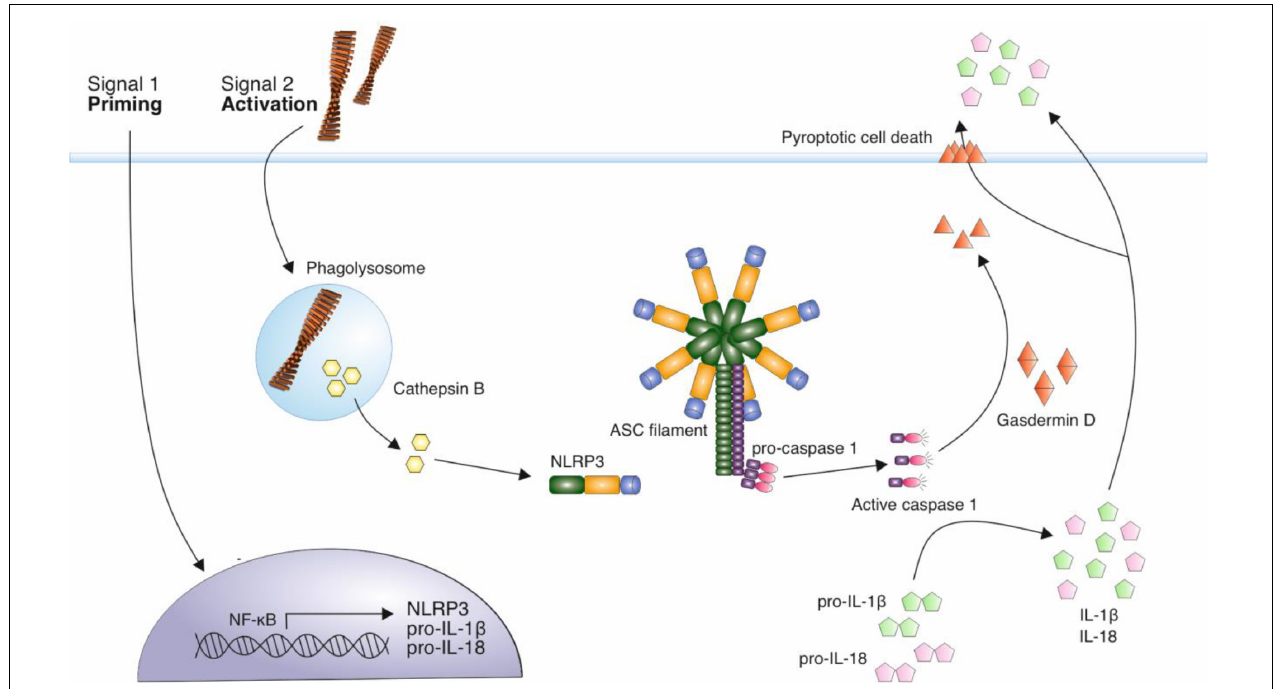
FIGURE 2 | Mechanism of NLRP3 activation by amyloid fibrils. A priming signal, such as LPS, leads to the increased expression of NLRP3 and precursor forms of inflammatory cytokines IL-1 β and IL-18. A β fibrils act as an activating stimulus via their internalization and disruption of lysosomes leading to the release of cathepsin B into the cytosol. This is thought to trigger the assembly of the NLRP3 inflammasome complex. This complex recruits ASC adaptor protein, which forms filaments. ASC filaments interact with pro-caspase 1 via CARD domains, resulting in caspase-1 activation. Active caspase 1 cleaves precursor forms of IL-1 β and IL-18, which are secreted from immune cells in their active form, contributing to neuroinflammation. Caspase 1 also cleaves gasdermin D, which forms pores in the cell membrane, eventually resulting in pyroptotic cell